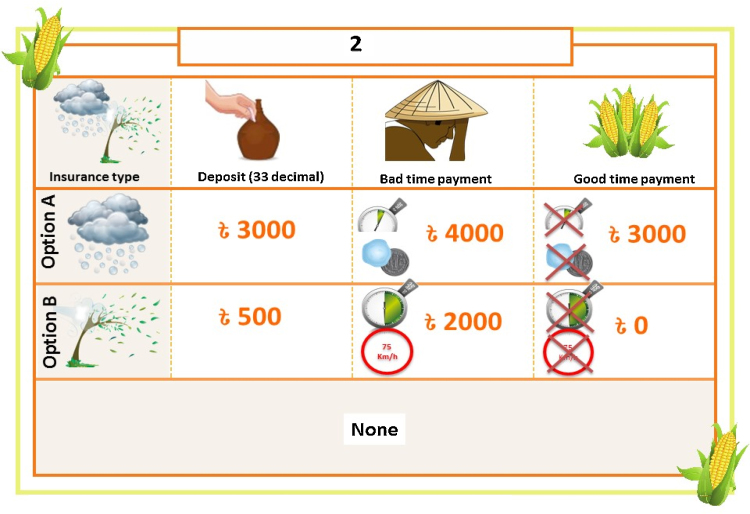
Example of a choice experiment question format shown to farmers (hail or windstorm crop damage).